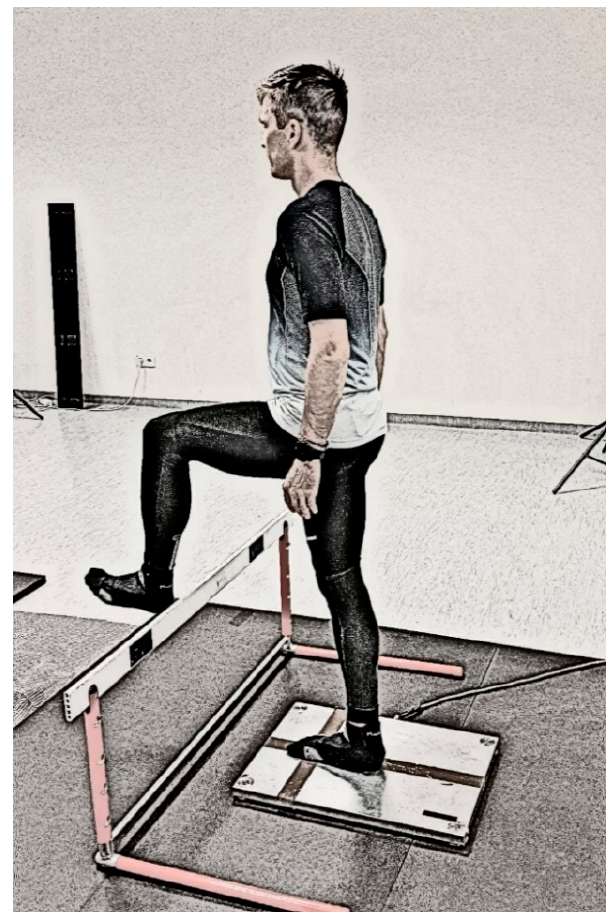
Figure 1. Hurdle attack—arms by the sides.